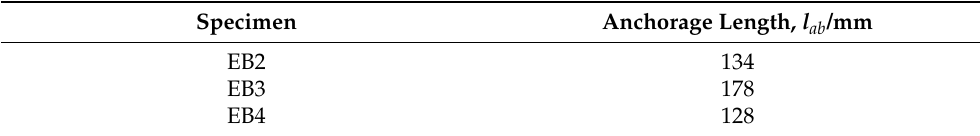
Table 7. Calculated anchorage length of the BFRP grid in the ECC matrix.